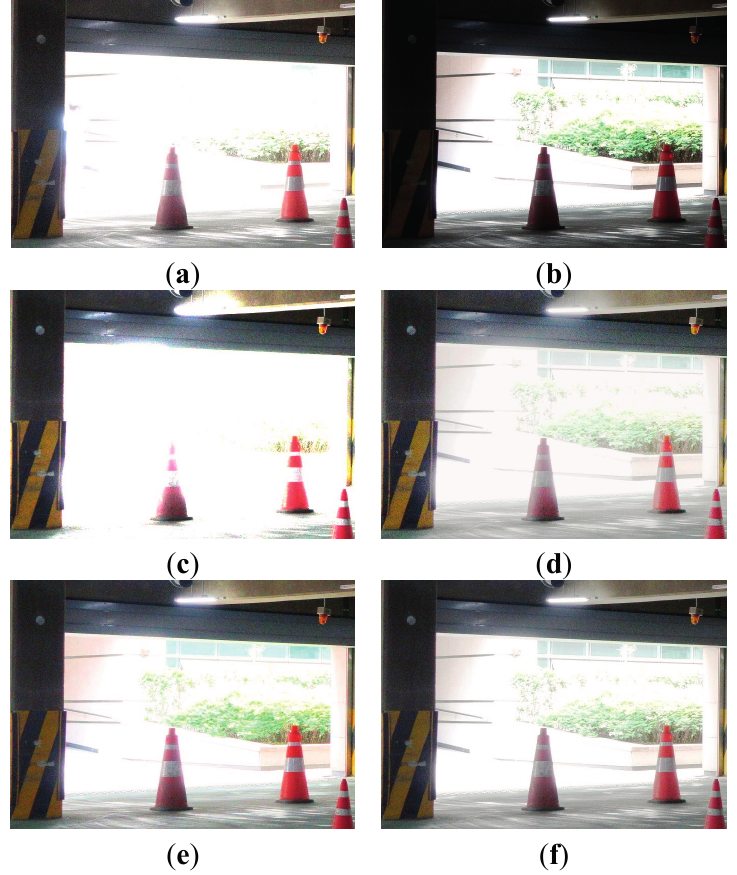
Figure 9. The magnified version of the red box shown in Figure 8a: ( a ) The reference image with ISO 3200 (EV = +1); ( b ) one-step lower exposure image using ISO 800 (EV = − 1); ( c ) enhanced image of (b) using ordinary 2 × 2 digital pixel binning; ( d ) enhanced image of (b) using Kim’s algorithm; ( e ) enhanced image of (b) using Jiang’s algorithm; and ( f ) enhanced image of (b) using the adaptive 2 × 2 digital pixel binning algorithm.